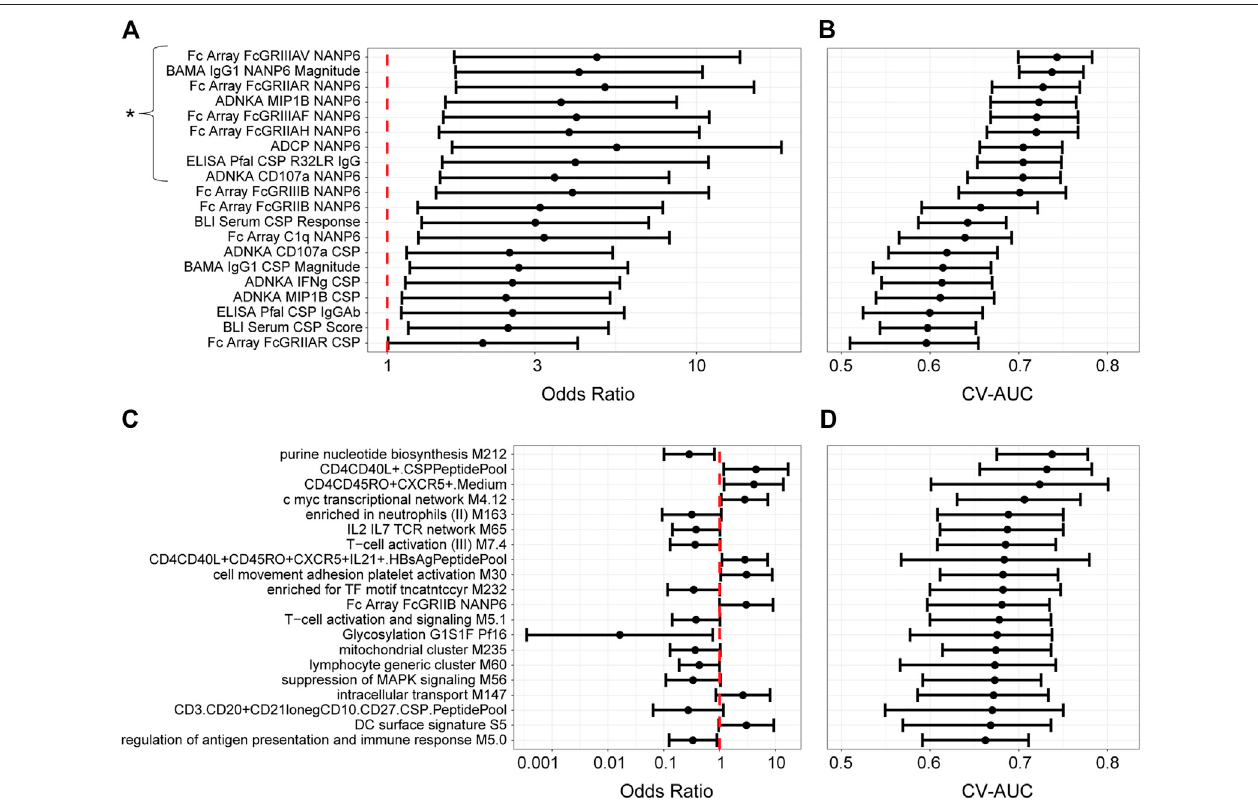
FIGURE3| UnivariatemodelswithMAL068(ARR+RRR)andwithMAL071(RRR+RRr)data. (A,C) Oddsratiosforprotectionagainstpatentparasitemiaperunit increase in the designated immune response variable on the day of challenge, for the 20 most predictive immune response variables in each data set (A, MAL068; C, MAL071). Whiskers extend through the 95% CI. The vertical dashed red line indicates an odds ratio of 1, i.e., that protection is equally likely whether the designated immuneresponseishigherorloweronchallengeday.TheasteriskinpanelAdesignatestheninevariablesthatweresigni fi cantlyassociatedwithprotection,having p -values < 0.2 after adjustment for false discovery rate. No variables were signi fi cantly associated with protection in panel (C) . (B, D) Forest plot of cross-validated AUC scores for the different univariate models for each data set (B, MAL068; D, MAL071). Dots show the cross-validated AUC calculated using the cvAUC package in R; whiskers extend through 95% empirical intervals of the 200 individual 5-fold cross-validation